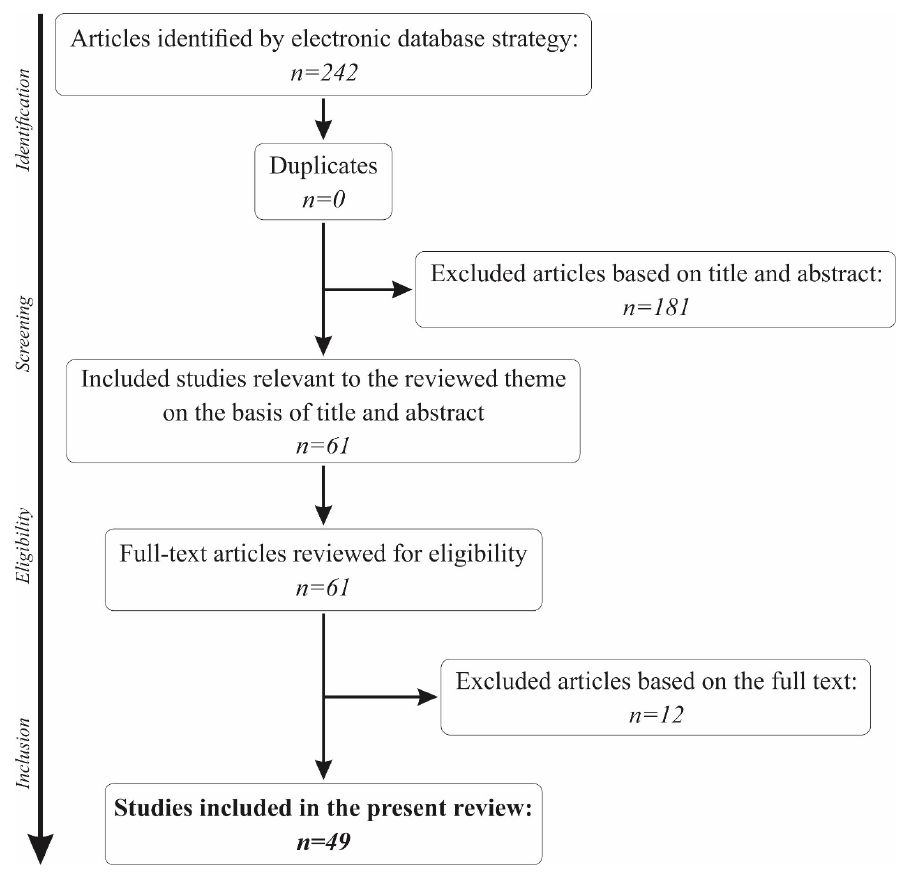
Figure 1. The paper selection algorithm for the present review.